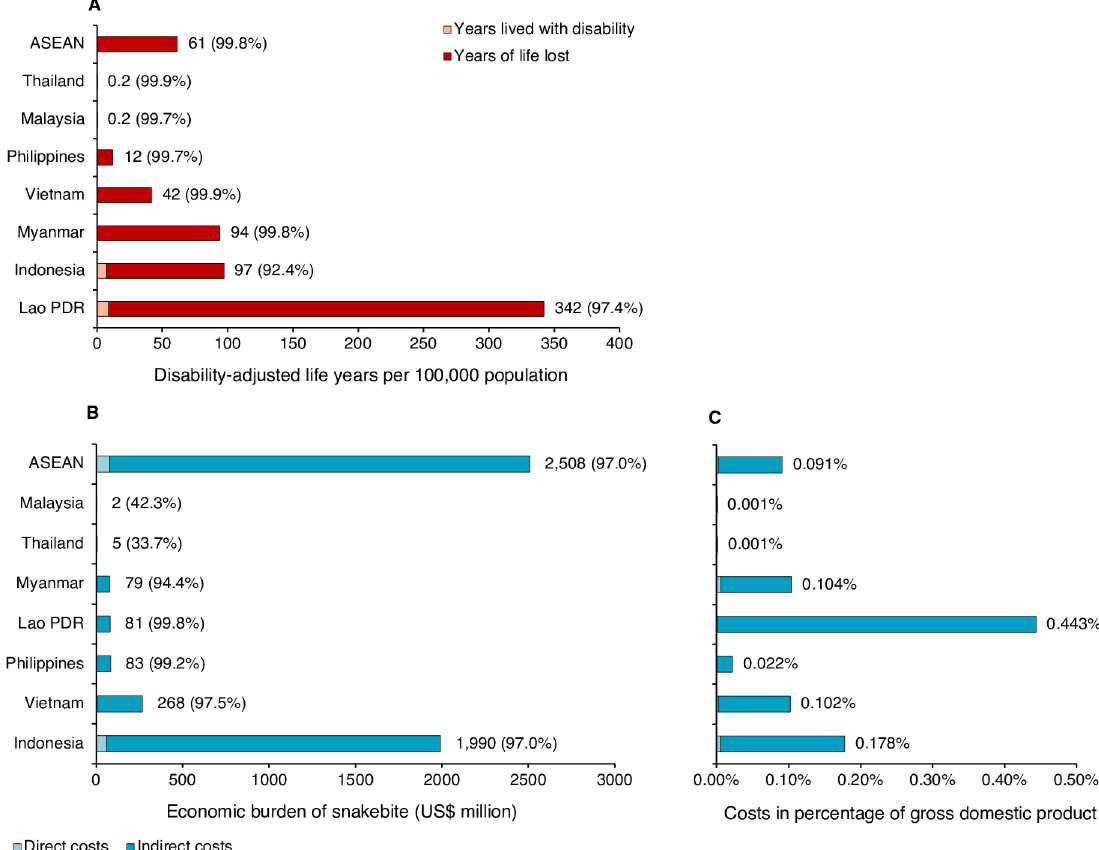
Fig 4. Estimated annual economic and disease burden of snakebite in ASEAN countries. (A) Disease burden of snakebite; data in parentheses are the percentages of disease burden attributable to years of life lost. (B) Costs in million USD; data in parentheses are the percentages of economic burden attributable to indirect costs. (C) Costs in percentage of gross domestic product; Main sources of information were national statistics and published research for the burden estimation of Malaysia, Thailand, and Myanmar. Published research and anecdotal evidence (local data, and expert opinion) were the main sources of information for the burden estimation of Vietnam, and Lao PDR. Anecdotal evidence was the only source of information for the burden estimation of Indonesia, and Philippines. Costs are presented as 2019 USD where 1 USD = 14,147.67 Indonesian Rupees = 51.80 Philippine Pesos = 23,050.24 Vietnamese Dong = 8,679.41 Lao Kip = 1,518.26 Myanmar Kyat. Abbreviation: GDP–gross domestic product; USD—US